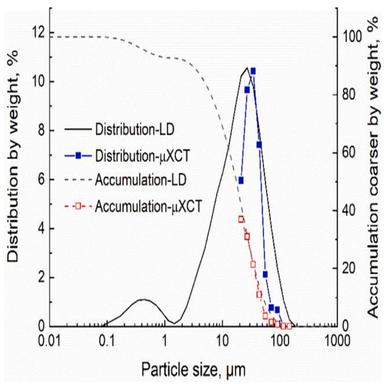
Particle size distribution in terms of weight percentage obtained from laser diffraction analysis and μXCT.